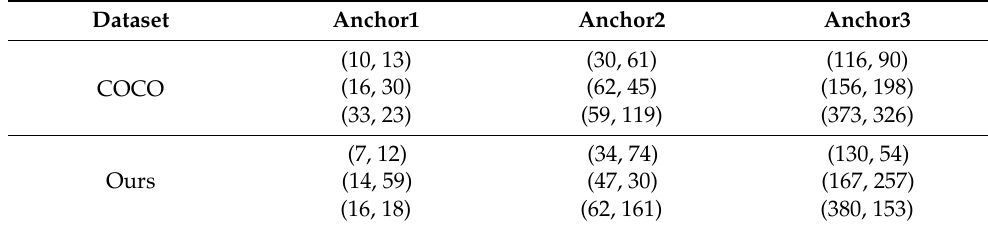
Table 1. Comparison of anchor